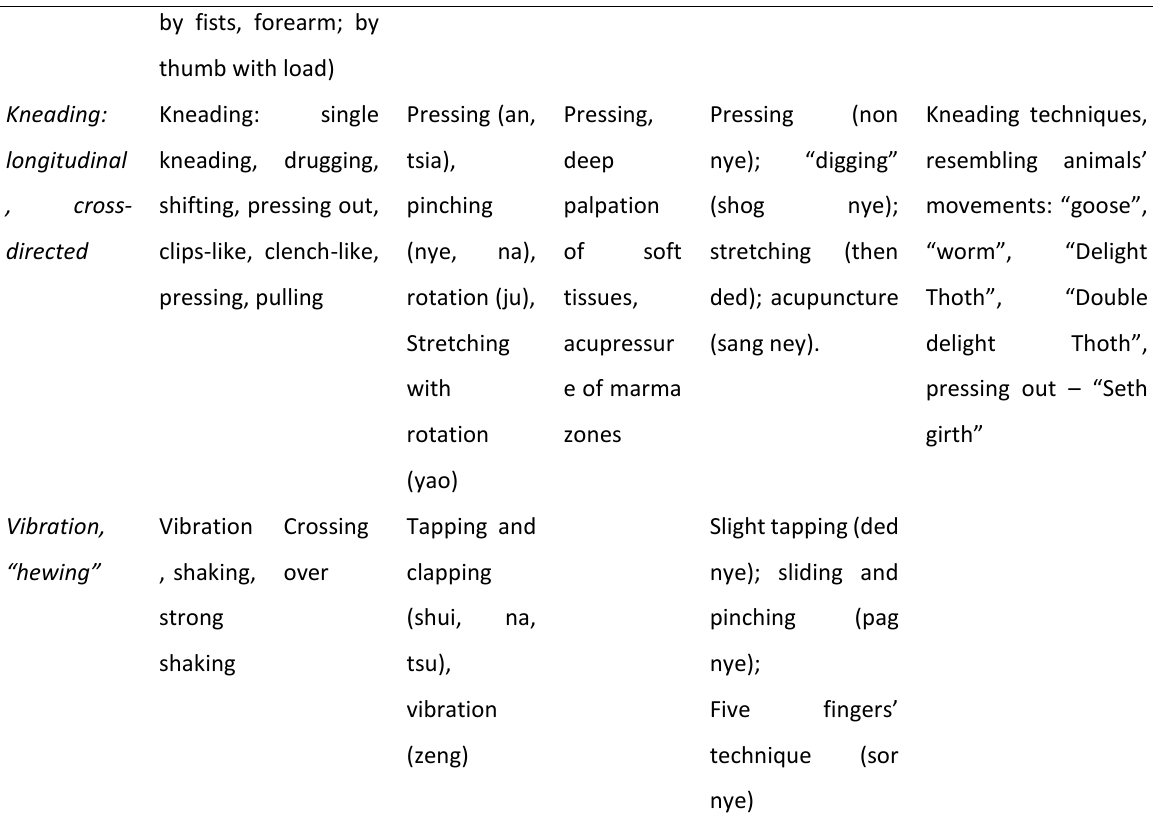
Table 2. Dynamic of testing indicators (by Luscher) in rehabilitation of students with neurological symptoms of vertebral osteochondrosis of first stage, different technologies and therapeutic massage methodic being